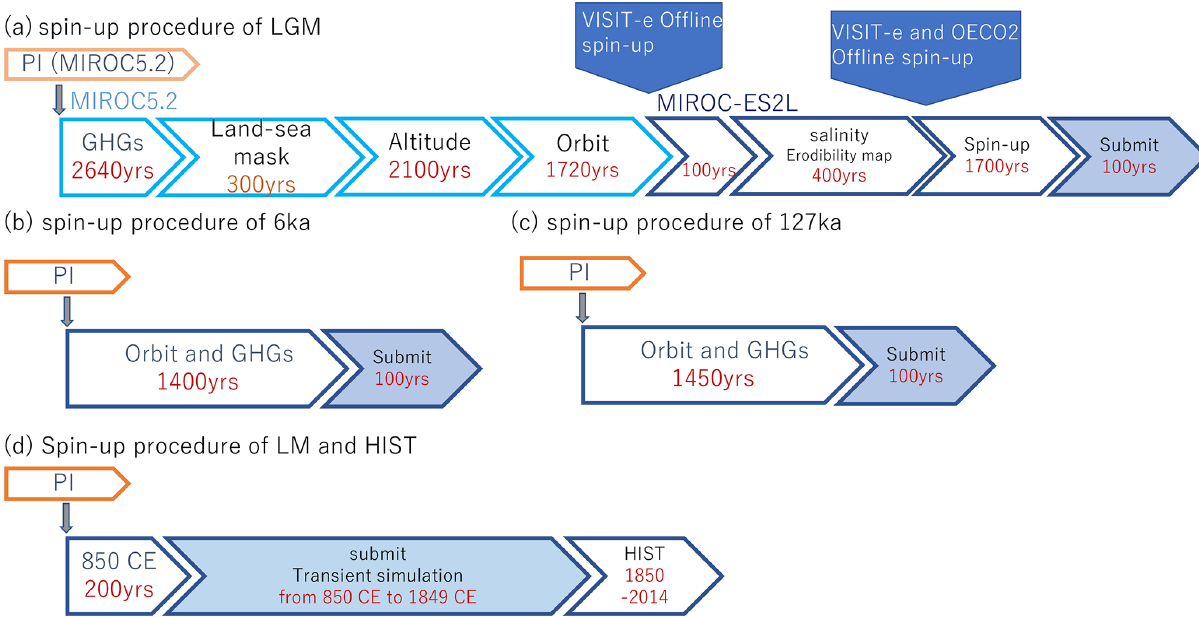
Figure 4. Schematic showing spin-up procedures of the following experiments: (a) LGM, (b) 6ka, (c) 127ka, and (d) LM and HIST. Shapes with dark orange or dark blue outlines represent experiments using MIROC-ES2L. Shapes with light orange or light blue outlines represent experiments using MIROC5.2. Shapes filled in pale blue represent model output submitted to